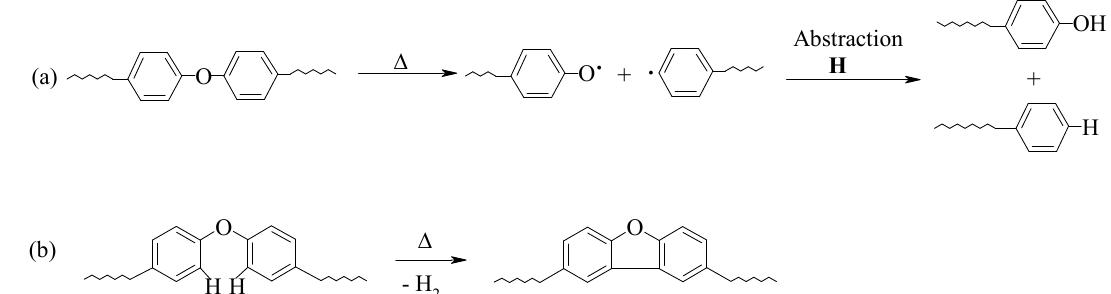
Figure 4. EI-DPMS spectra of the P(ESES) sample recorded in the temperature ranges ( a ) 430–480 °C and ( b ) 480–500 °C. (a) The symbol + indicates the presence of the ions; - denotes their absence.